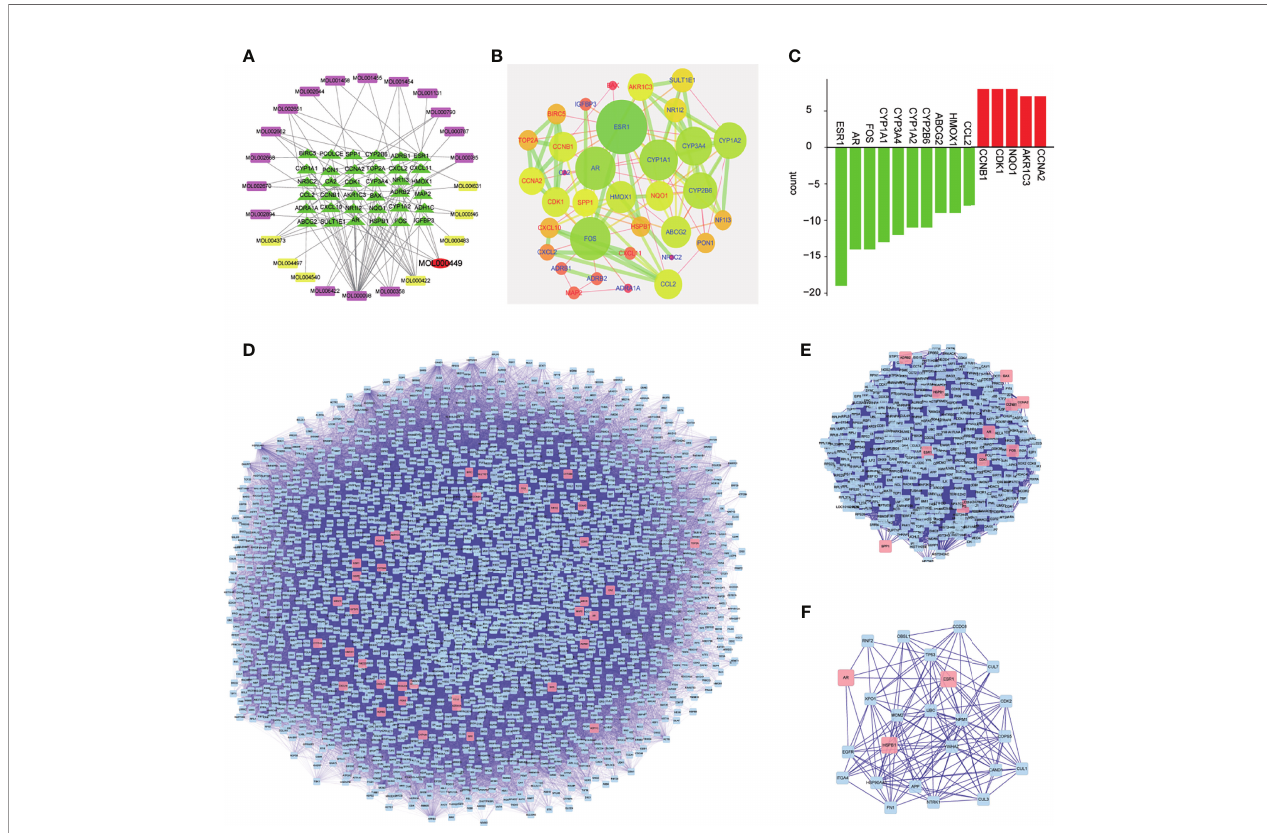
FIGURE 2 | Chinese medicine compound regulation network, core genes, and analysis of PPI and network topology. (A) Purple represents the active ingredient of Phellodendron, yellow represents the active ingredient of Anemarrhena, red is the active ingredient shared by both, green is the target gene corresponding to the active ingredient. (B) The nodes represent genes. The larger the nodes, the more important genes are. The color scale changes from red to green, and the closer the color is to green, the more important the gene is. The node label red represents high-expressing genes and blue represents low-expressing genes. Besides, the line indicates the strength of the association between genes, and the thicker the line, the stronger the degree of association. (C) The abscissa represents the gene name, red represents up-regulated genes while green represents down-regulated genes, and the ordinate represents the number of genes. (D – F) Analysis of PPI and network